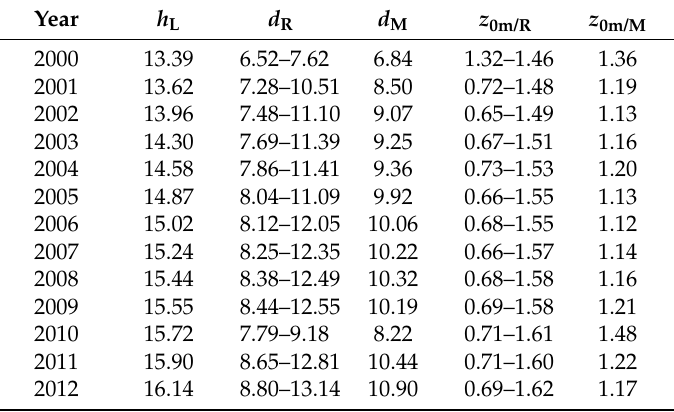
Figure 2. The fitting regression of forest Lorey’s height ( a ) and the frontal area index (FAI) ( b ) against the forest aboveground biomass (AGB) based on measurements. Table 2. Statistics for the interannual forest Lorey’s heights ( h L ) (unit: meter), d ( d R : value range; d M : mean value) (unit: meter), and z 0m ( z 0m/R : value range; z 0m/M : mean value) (unit: meter) from 2000 to 2012 at the EC site.